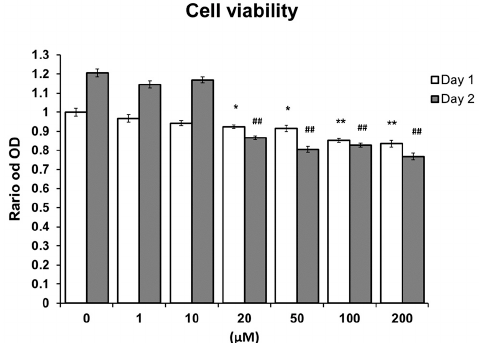
Figure 1. Effects of ( − )-epigallocatechin gallate (EGCG) on ST2 cells in MTS. There was no significant change in the MTS assay and cell cycle after EGCG treatment from 1 to 200 µmol/L for 24 and 48 h. With the treatment of EGCG, the viability of ST2 cells was not affected by EGCG at both 1 and 10 µmol/L (both p > 0.05). However, decrease via viability of ST2 cells was noted in EGCG concentrations higher than 20 µmol/L. *: p < 0.05, **: p < 0.01, compared with day 1 0 µM. ##: p < 0.01 Compared with day 2 0 µM.